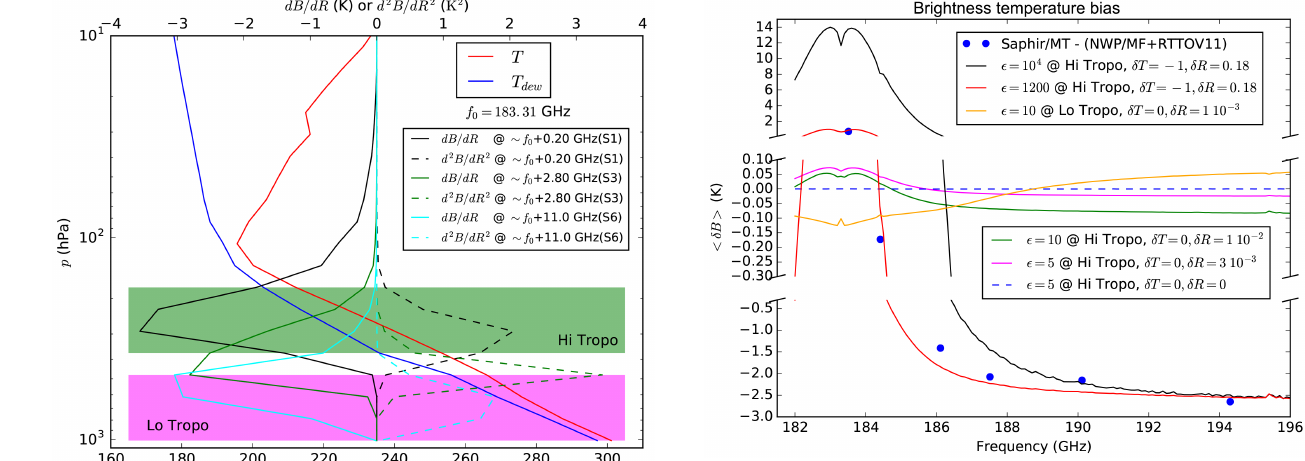
Figure 3. Temperature and humidity profiles, as dew point temper- ature, used in this paper. Highlighted are the regions denoted as “Hi Tropo” and “Lo Tropo” in Fig. 4. Jacobians, dB/dR , and second derivatives, d 2 B/dR 2 , of brightness temperature vs. humidity for a few close to SAPHIR channels are also plotted. Precise frequen- cies are: 183.50GHz ≈ S1 channel, 186.10GHz ≈ S3 channel and 194.30GHz ≈ S6 channel.